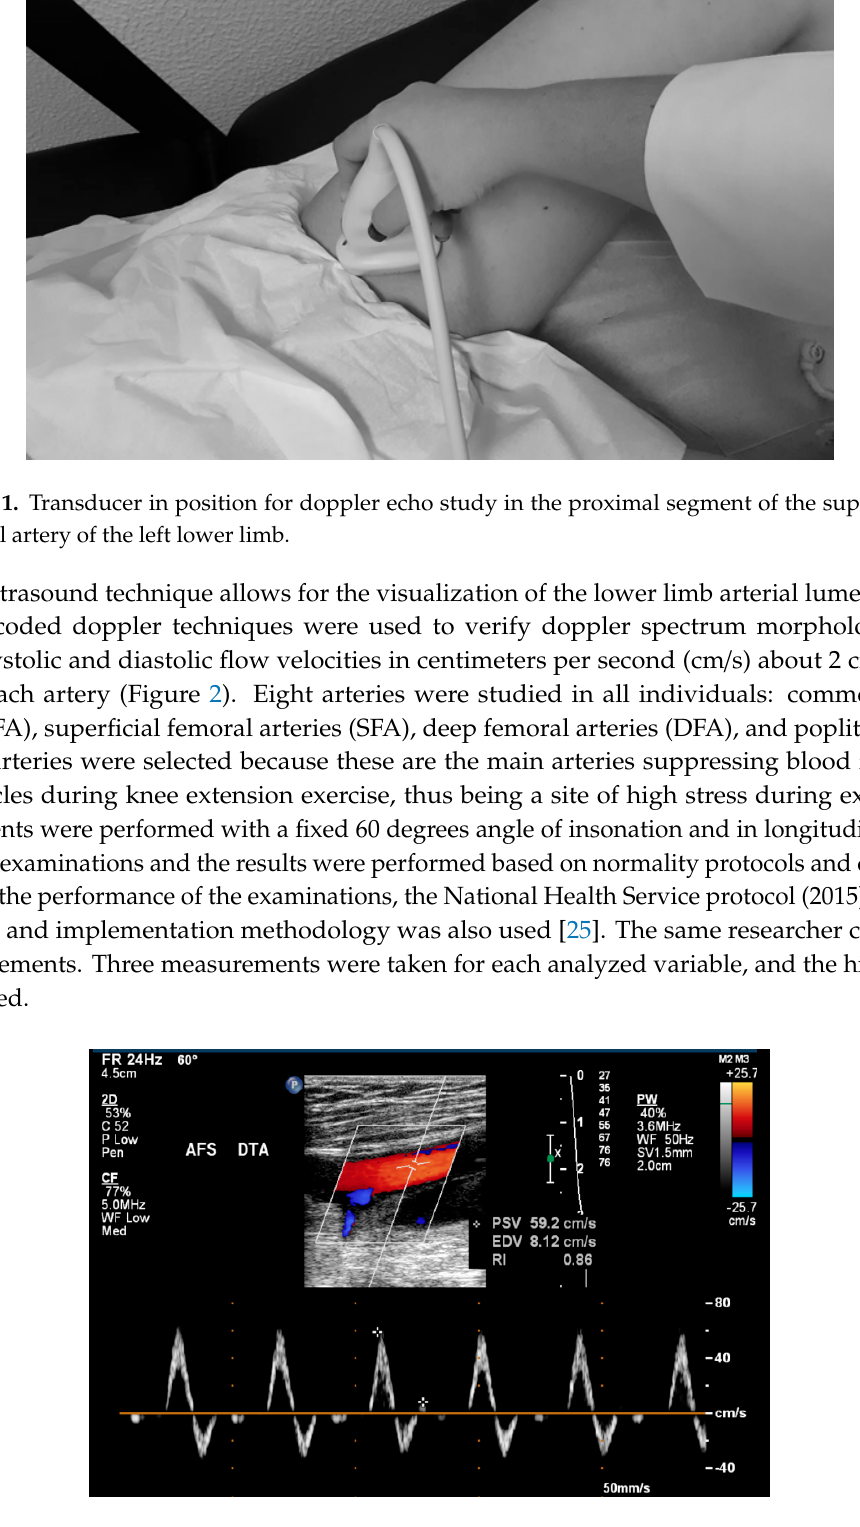
Figure 2. Measurement of systolic and diastolic flow velocities in (cm/s) of the right common femoral artery by lower limb arterial doppler ultrasound.